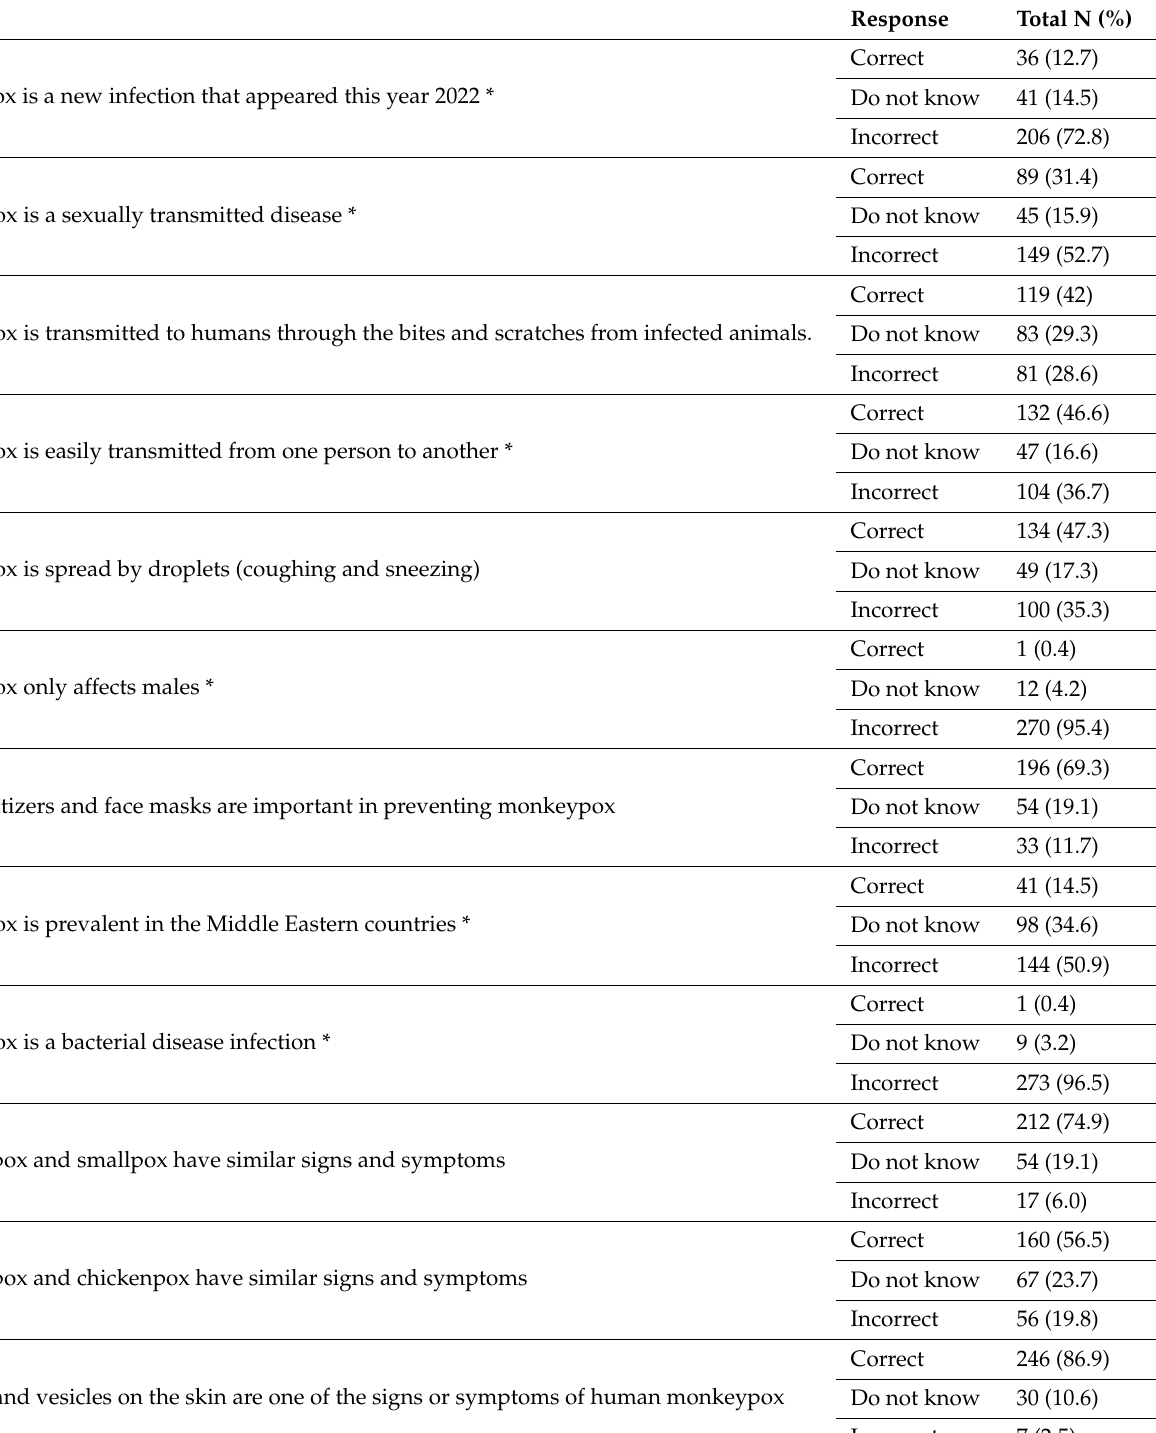
Table 1. Responses of physicians who participated in the study to the knowledge questions about the monkeypox disease (n =